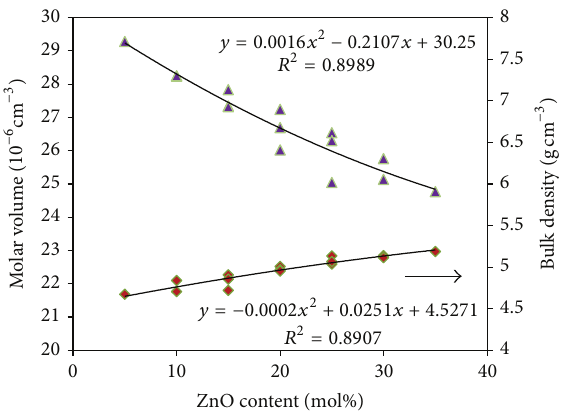
Figure 1: The variation of density and molar volume of ZOFT glass series at various ZnO contents (mol%).